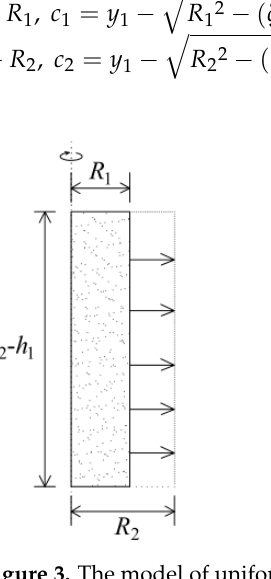
where a and b are the lower and upper x limits of the integral, respectively; c and d represent the lower and upper y limits of the integral, respectively; e and f denote the lower and upper z limits of the integral, respectively. Subscripts 1 and 2 indicate the state of the volume expansion of the soil before and after grouting, respectively. The formulas for calculating the lower and upper limits of the integral are defined as